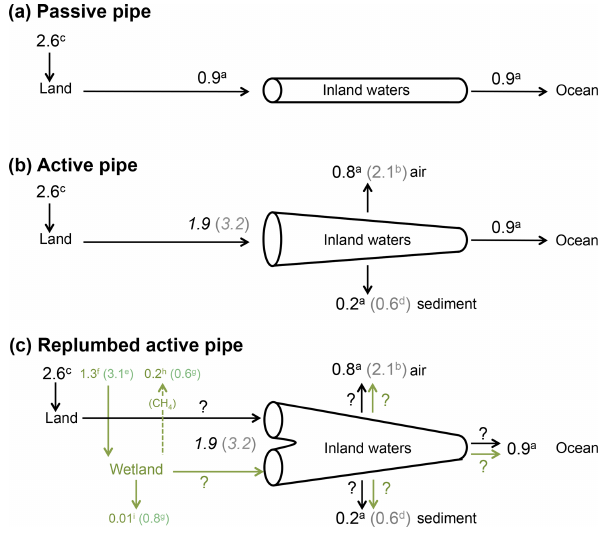
Figure 1. An update of the active pipe concept, including wetlands in the C budget of inland waters. a From Cole et al. (2007); b from Raymond et al. (2013) (note that the estimate of global CO 2 out- gassing from Cole et al., 2007, is similar to that of Lauerwald et al., 2015); c calculated as the difference between land use change and net land flux in Ciais et al. (2013); d from Tranvik et al. (2009); e from Lu et al. (2016); f from Lu et al. (2016) corrected for a global wetland surface area of Downing et al. (2009); g from Mitsch et al. (2013); h from Saunois et al. (2016); i corrected from Mitsch et al. (2013), according to Bridgham et al. (2014). Numbers in ital- ics are calculated as the sum of all others fluxes and include a high (grey) and a low (black) estimate. Black arrows represent C origi- nating from well-drained, terrestrial ecosystems, and green arrows represent wetland